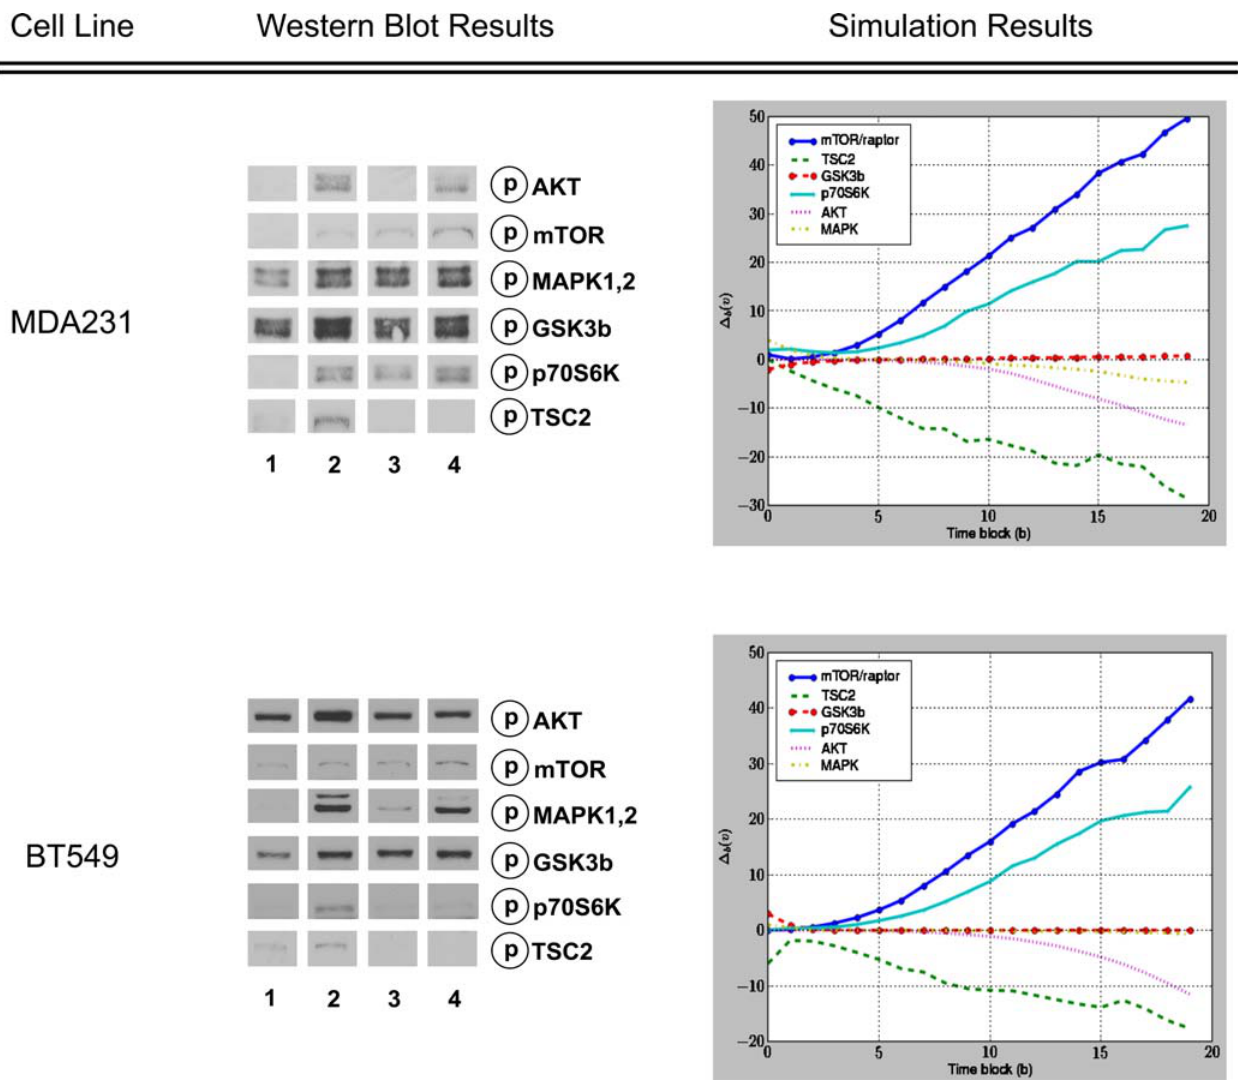
Figure 9. The Results of the TSC2 Perturbation Experiments and Simulations. In the western blots, columns (or lanes) are as follows: (1) non-targeting (NT) control siRNA, (2) NT siRNA + EGF, (3) TSC2 siRNA, (4) TSC2 siRNA + EGF. The effect of the TSC2 siRNA on a given molecule can be assessed by comparing column 4 against column 2. For each molecule in the western blot, there is a corresponding simulation curve showing the predicted change in protein activity over time. For the purposes of this analysis, we compared the concentration change after 20 time steps (the left- most data points in the plots) for each molecule. Each simulation point corresponds to the average of 400 measurements that were computed using the procedure described in Figure 8. Experimentally derived initial states were used in the simulations. The results of both the experiments and simulations are qualitatively summarized in Table 3.